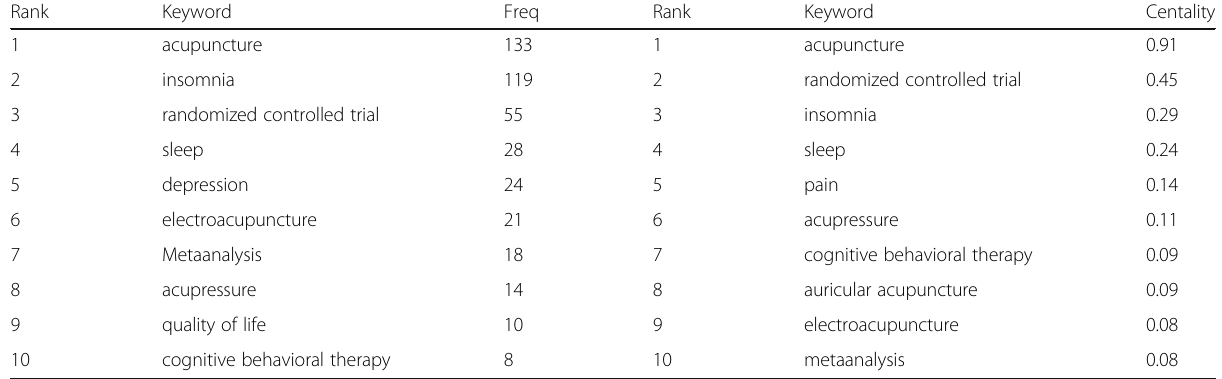
Table 6 Top 10 keyword related to acupuncture for insomnia